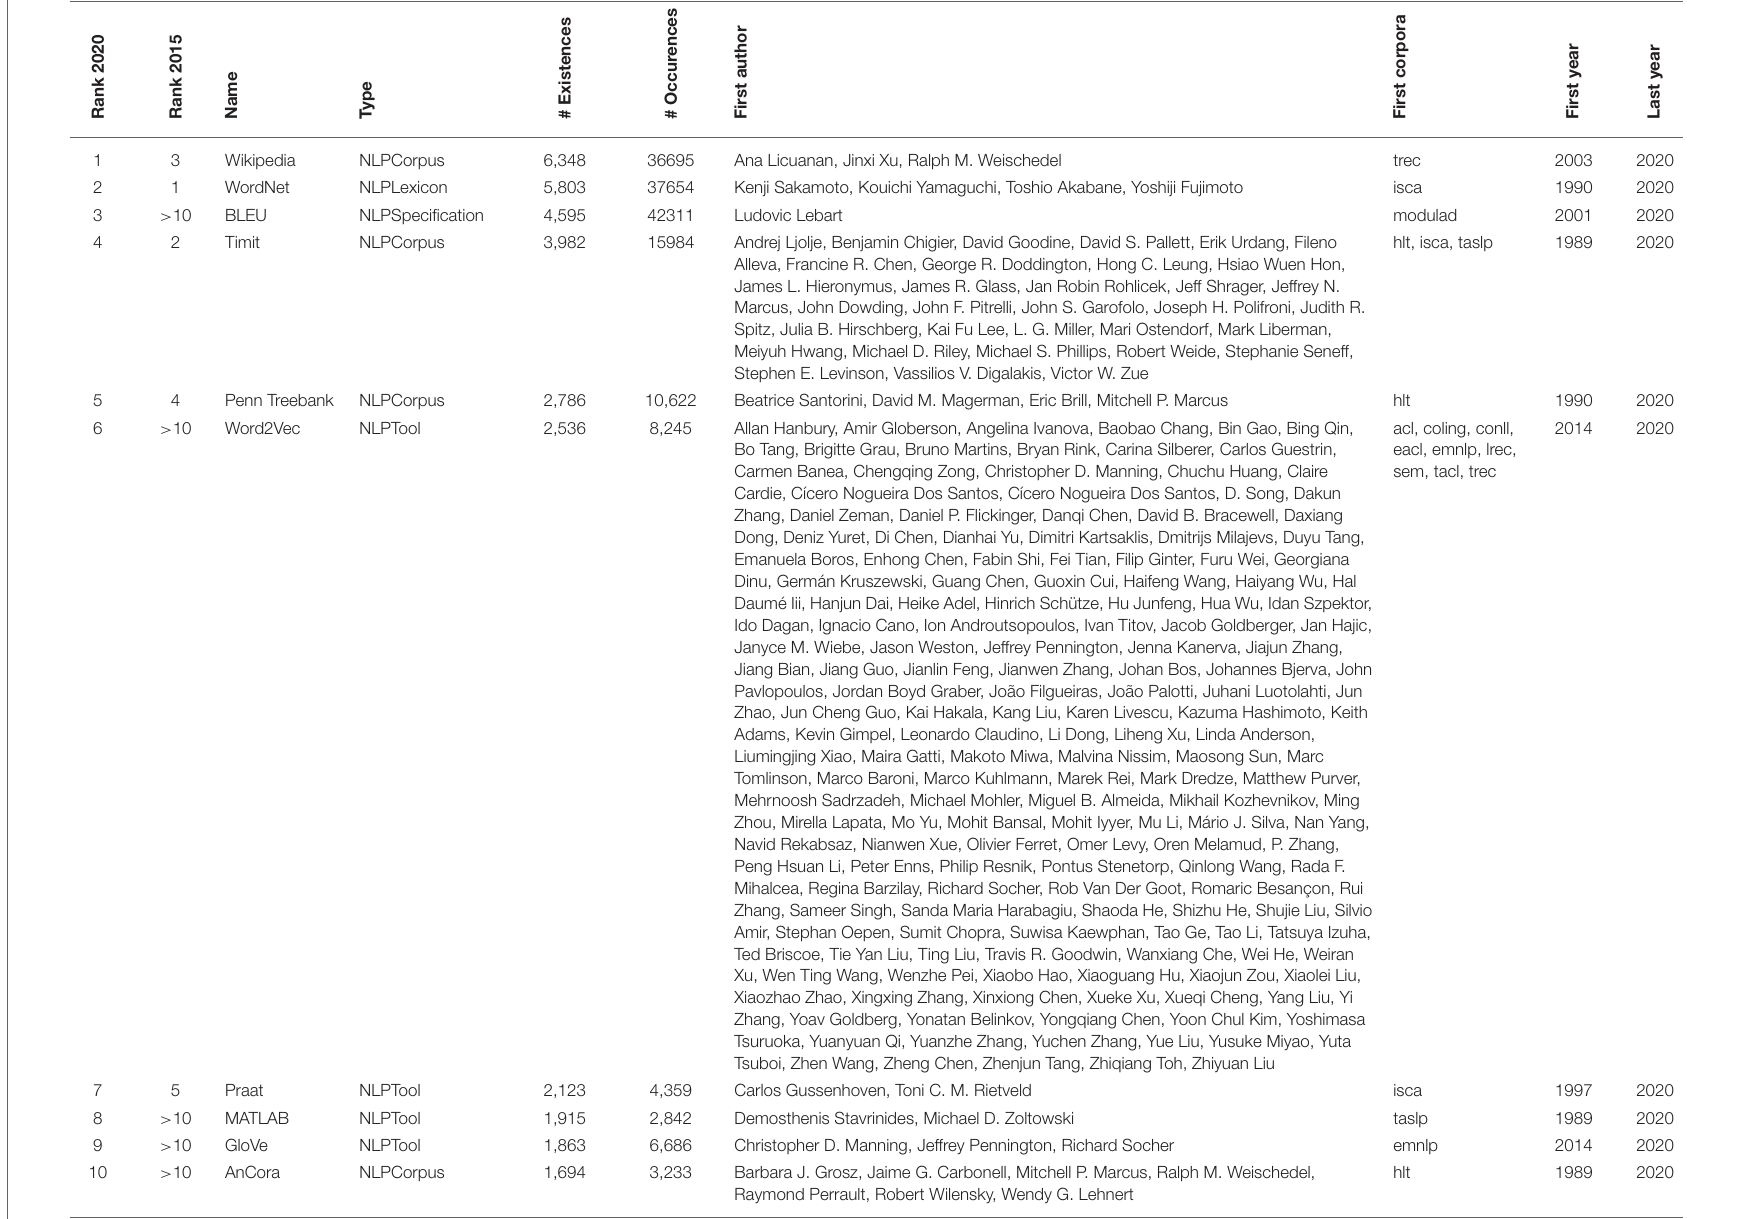
TABLE 29 | Presence of the LRE Map language resources in NLP4NLP + 5 articles (2020 compared with 2015).